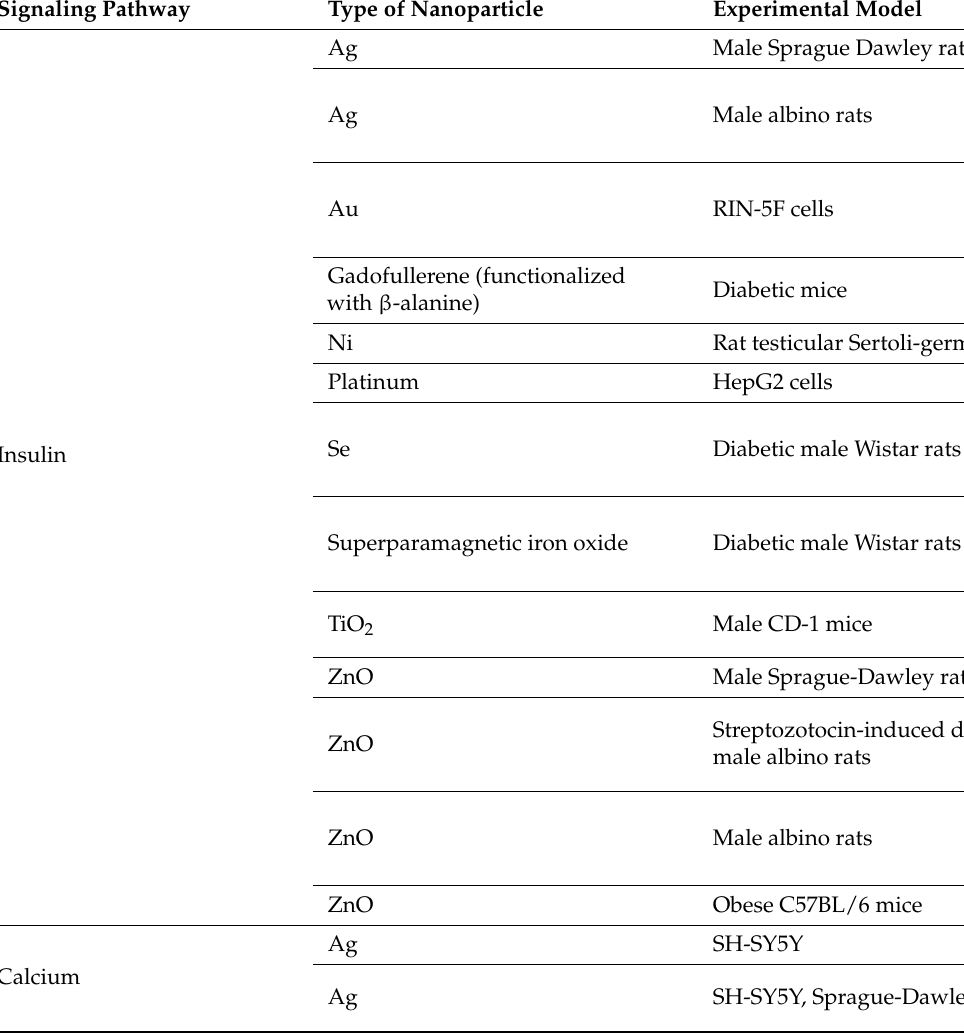
Table 6. Summary Table of effects of nanoparticles on insulin, calcium, and nitric oxide signaling